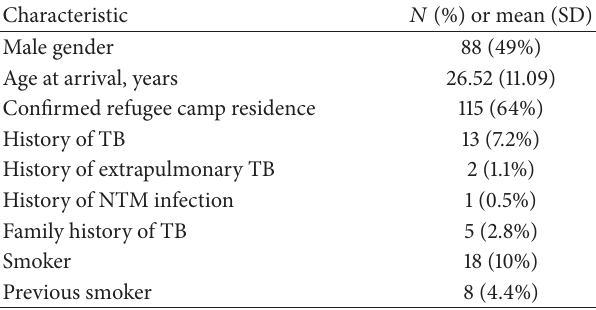
Table 1: Demographic information ( 𝑁 = 180